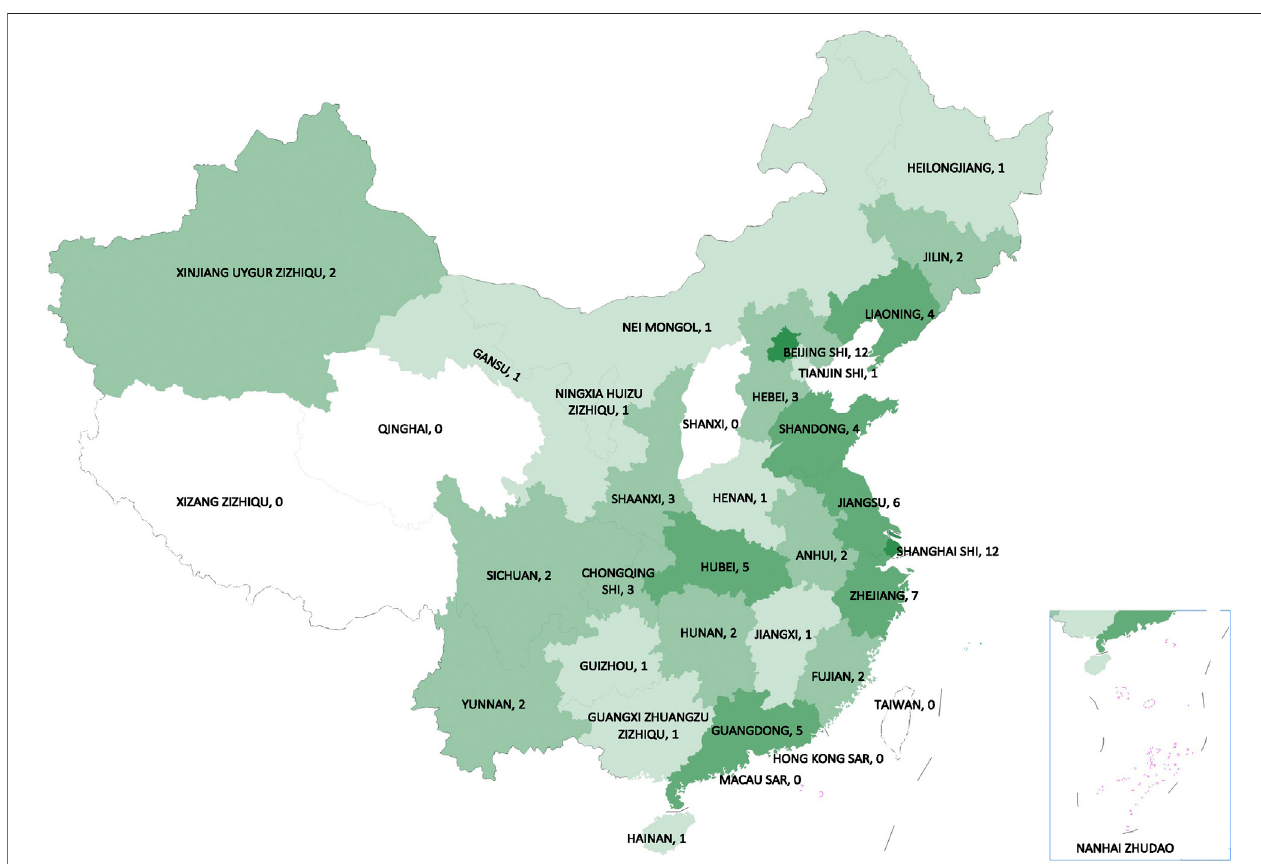
FIGURE1| The regionaldistributionmap ofregistered hospitals from NRDRS (as ofMar. 24,2021). (The NationalRare Diseases Registry System ofChina, 2021).